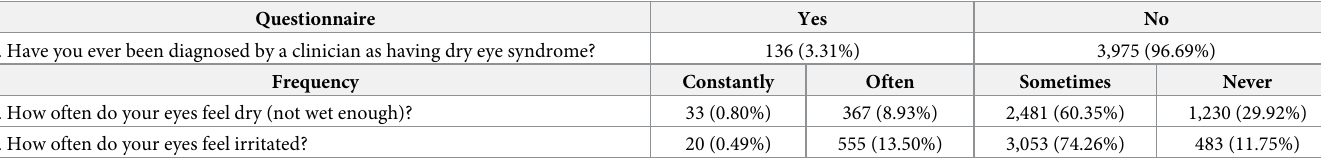
Table 2. Dry eye questionnaire (N = 4,111